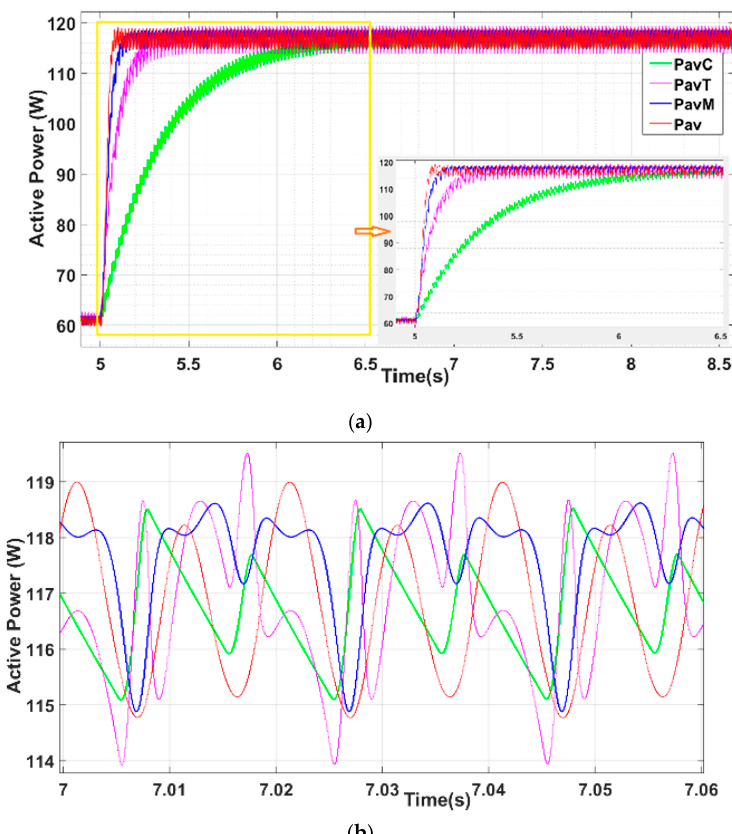
Figure 9. Active power transient after abrupt load change at t = 5 s, and its detail in steady-state: Pav (red), PavM (blue), PavT (magenta), and PavC (green). ( a ) Transient after the load step. ( b ) Steady-state ripple of the calculated active powers.